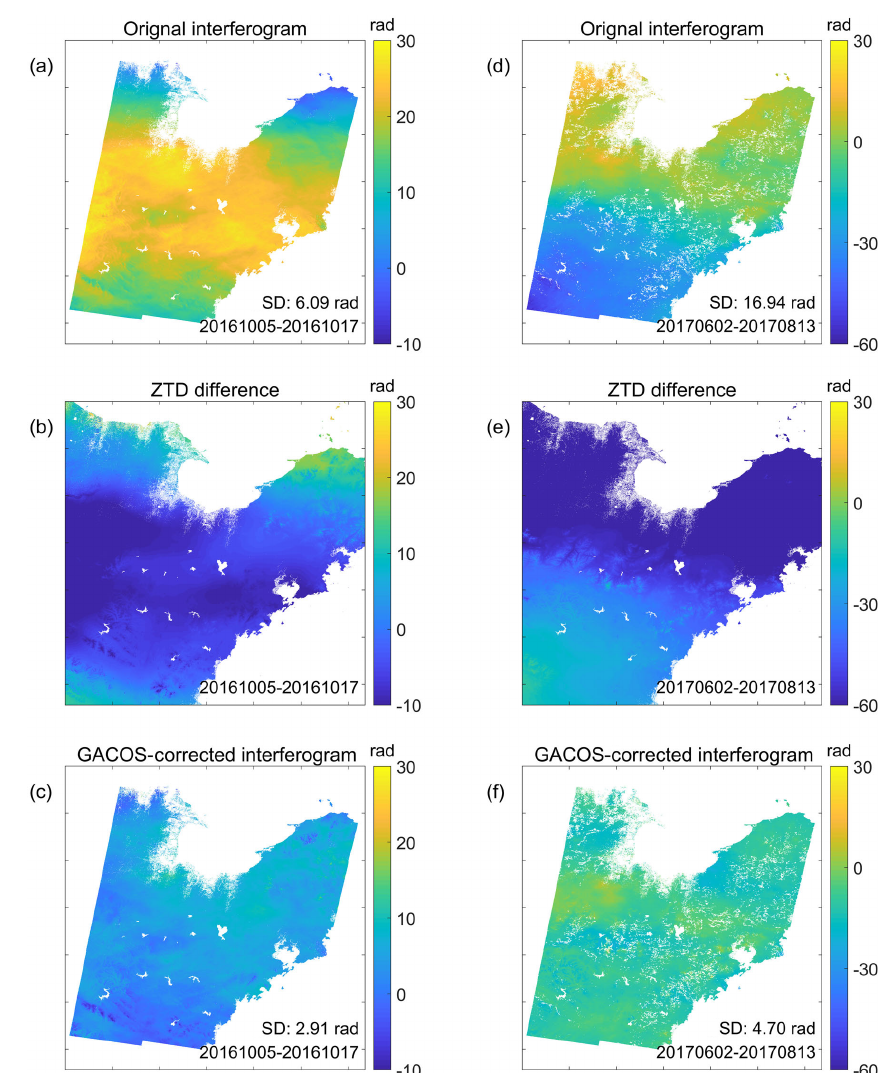
Figure 5. GACOS ZTD difference (b, e) and interferograms before (a, d) and after (c, f) corrections for two pairs with different